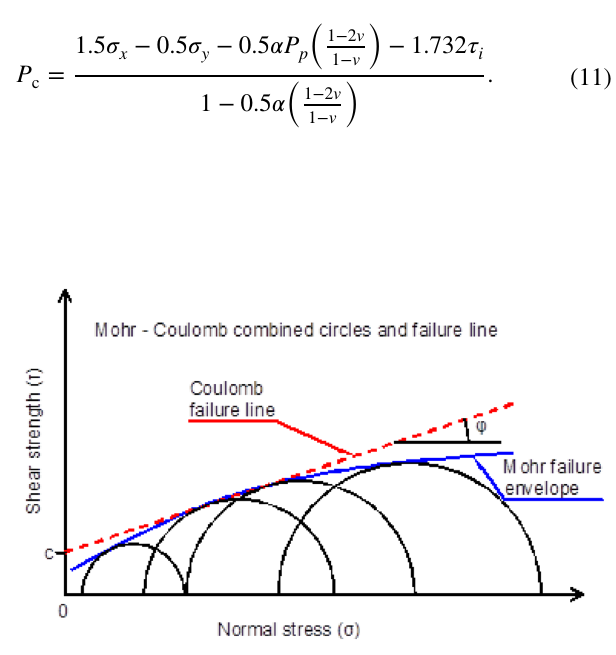
Fig. 9 Mohr–Coulomb criterion for failure. Source : Holtz and Kovacs